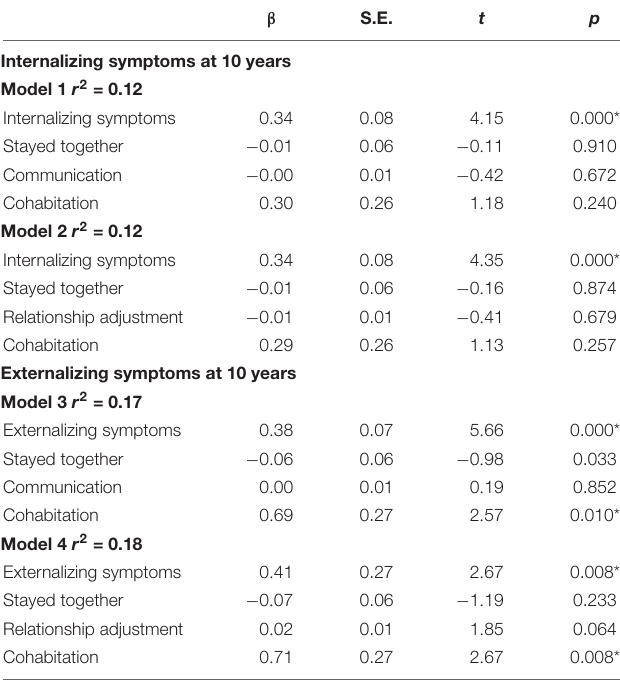
When the covariates age, income, and treatment status were included, none of the results changed. All independent variables indicate baseline levels except staying together which reflects whether the couple stayed together (vs. separated/divorced) over the 10 year period. Bonferroni correction applied, *p <